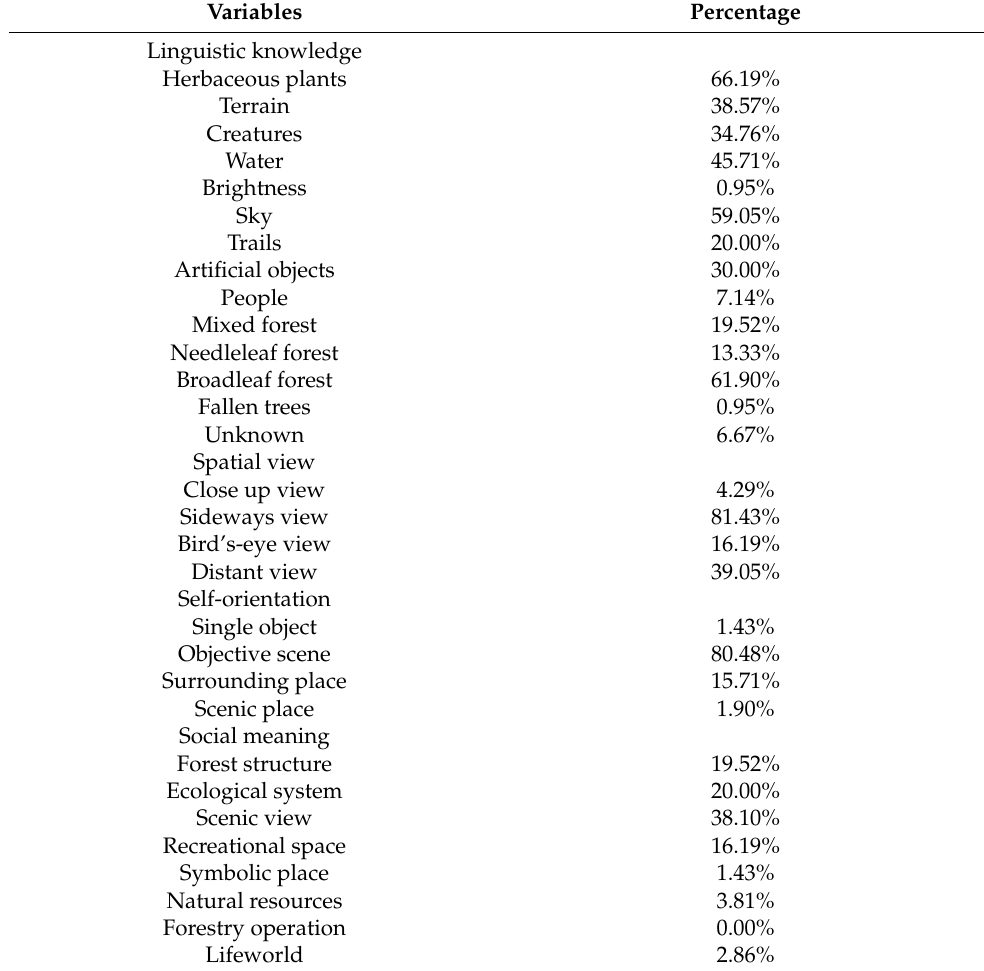
Table 1. Explanation and analysis of basic characteristics of forest landscape image sketches.